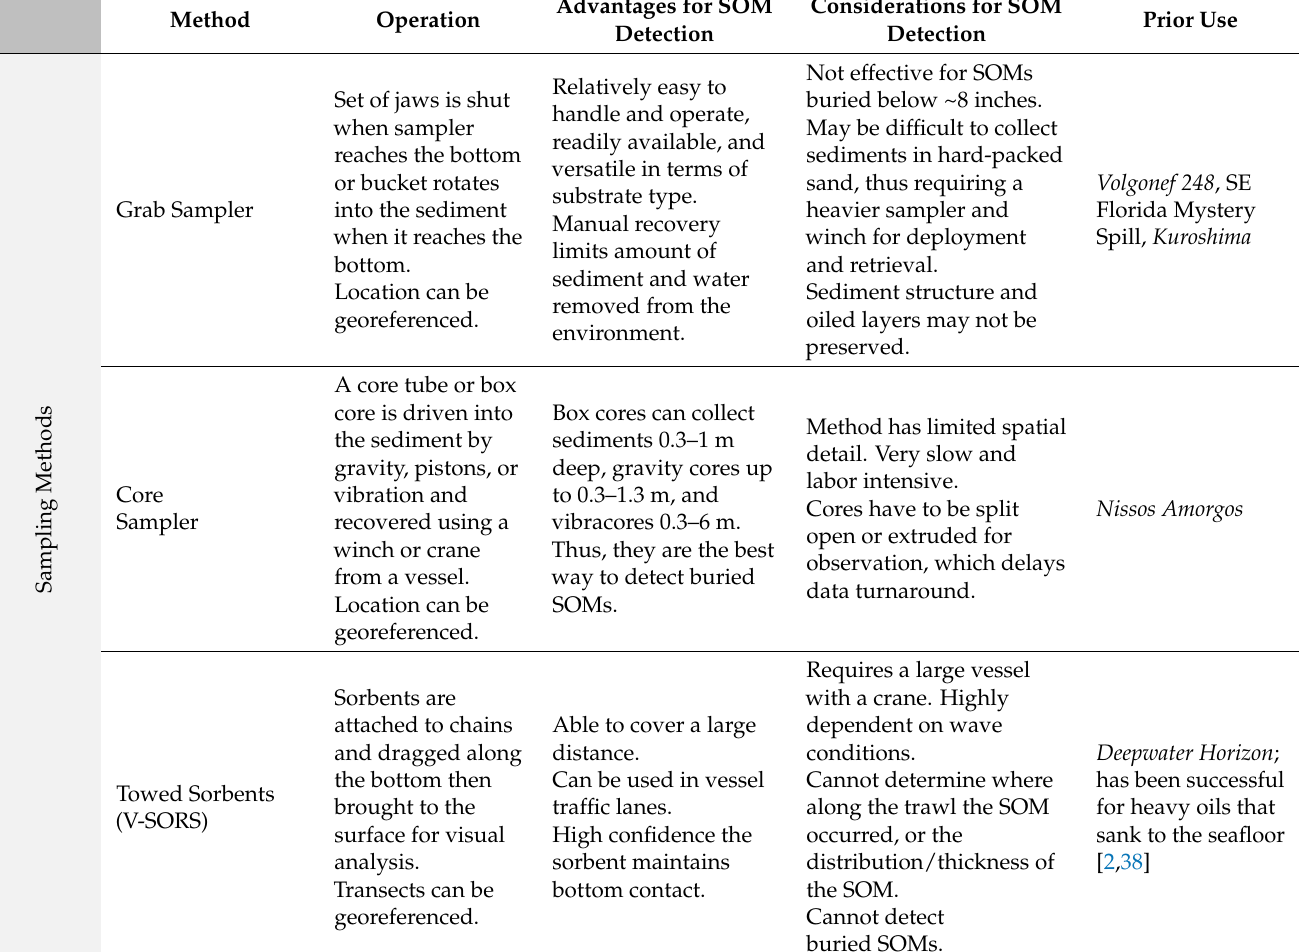
Table 4. SOMs detection using sampling and other methods for open-water environments seaward of the surf